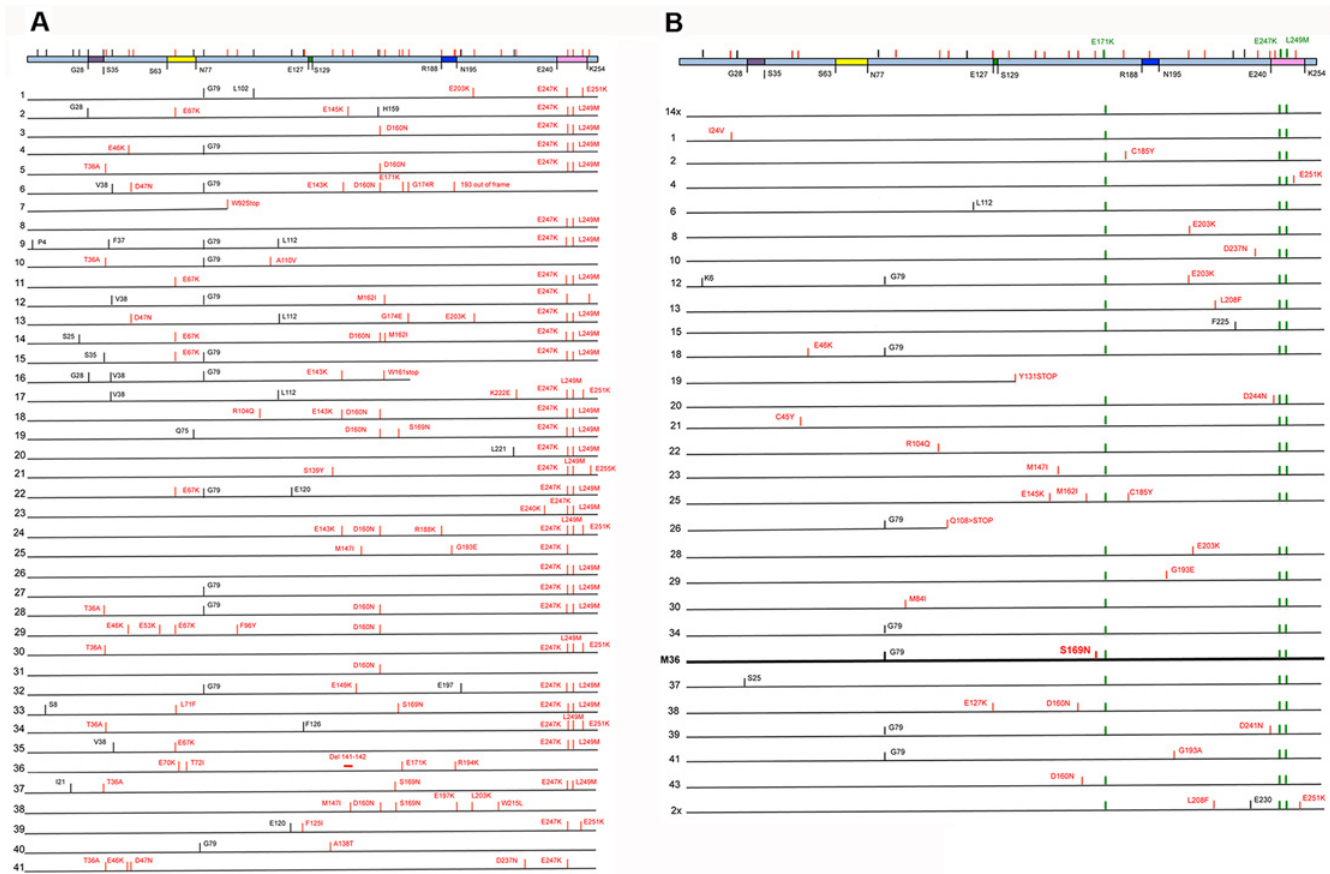
Fig 3. Position of the mutations found in the individual clones. In each panel, the dCK protein is represented (top of the drawing) as a pale blue box with the main structural motifs given in color (the first and last aminoacid of each motif is given below the box): purple, P-loop; yellow, insert; green, ERS; blue, lid; pink, base sensing loop; as defined in [28]. For each panel, a cumulative map of the positions that were mutated is provided at the top of the box with aminoacid substitutions given in red, while aminoacids that did not change but with associated codons that carried synonymous mutations given in black. Panels A and B respectively show the patterns observed for the random and directed libraries, respectively. Two deletion were also found: one single nucleotide deletion in clone 6 indicated as "193 out of frame", and a two-nucleotide deletion (positions 141 – 142) in clone 36 indicated by a red horizontal line. In Panel B, clone 36 (corresponding to M36 in the main text, for Mutant 36) is given in bold.